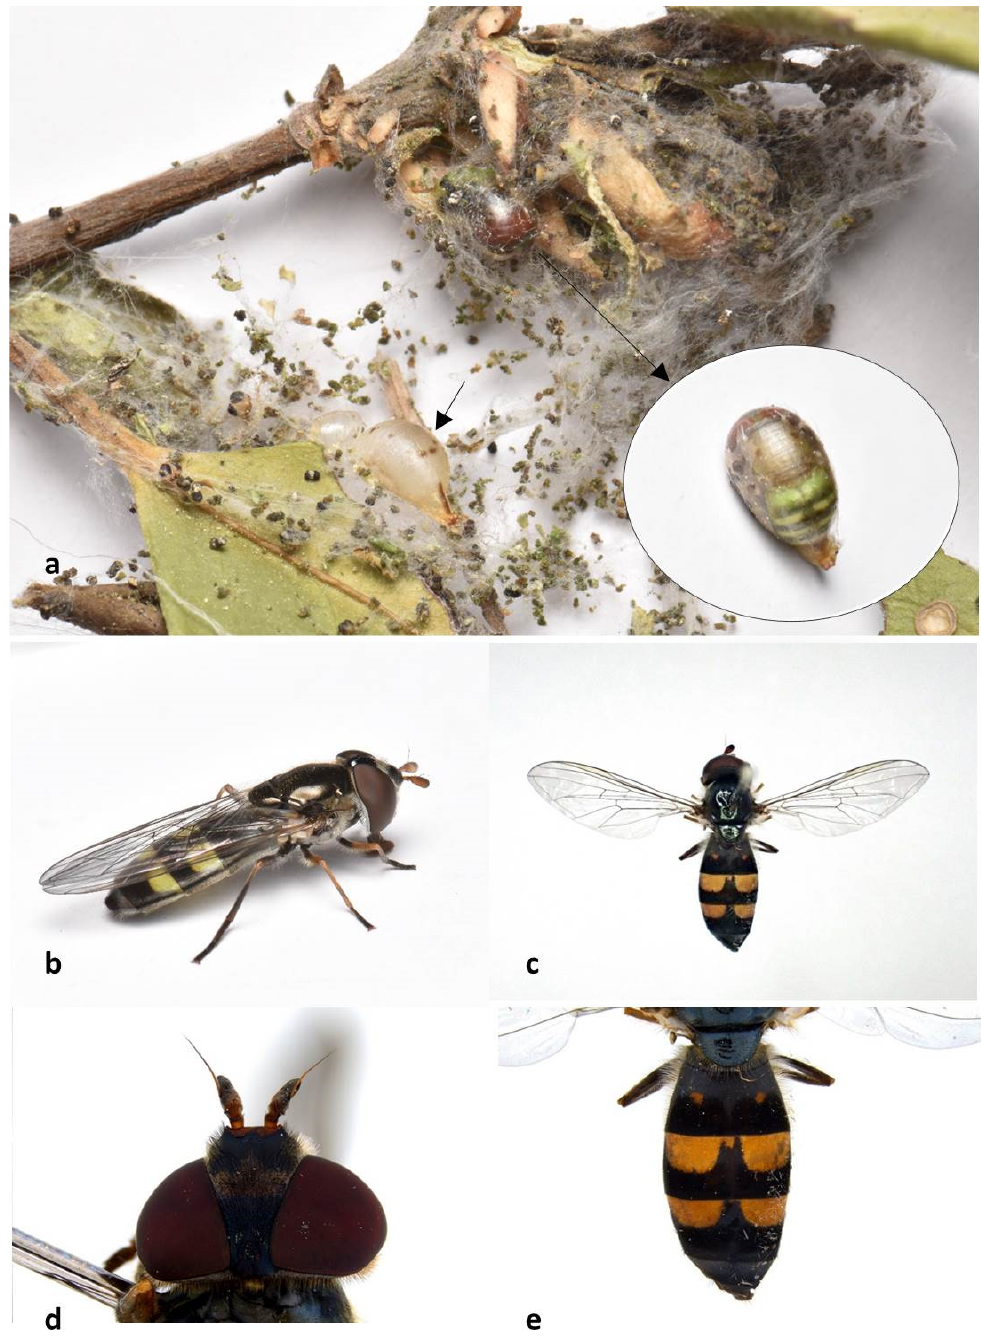
Figure 7. Xanthandrus comtus , a natural enemy of Yponomeuta meguronis : ( a ) pupa and exuvium; ( b ) ecological photo; ( c ) dorsal view; ( d ) head; and ( e ) abdomen.